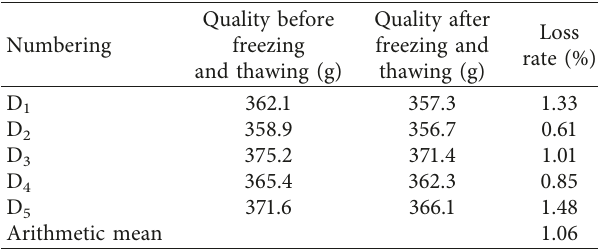
Table 4: Mass loss rate of active magnesium oxide carbonized block after freeze-thaw.